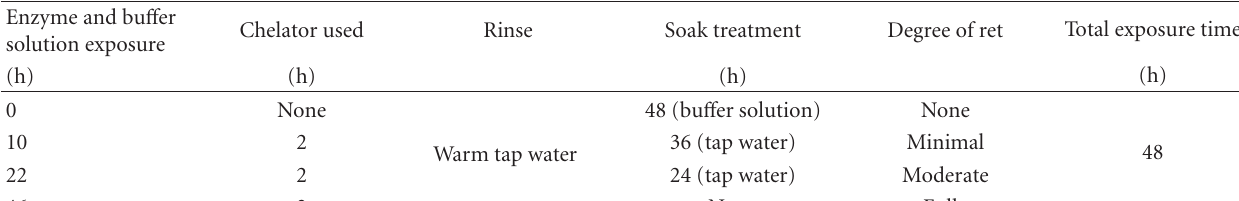
Table 1: Treatments utilized in enzyme-retting flax fibers.